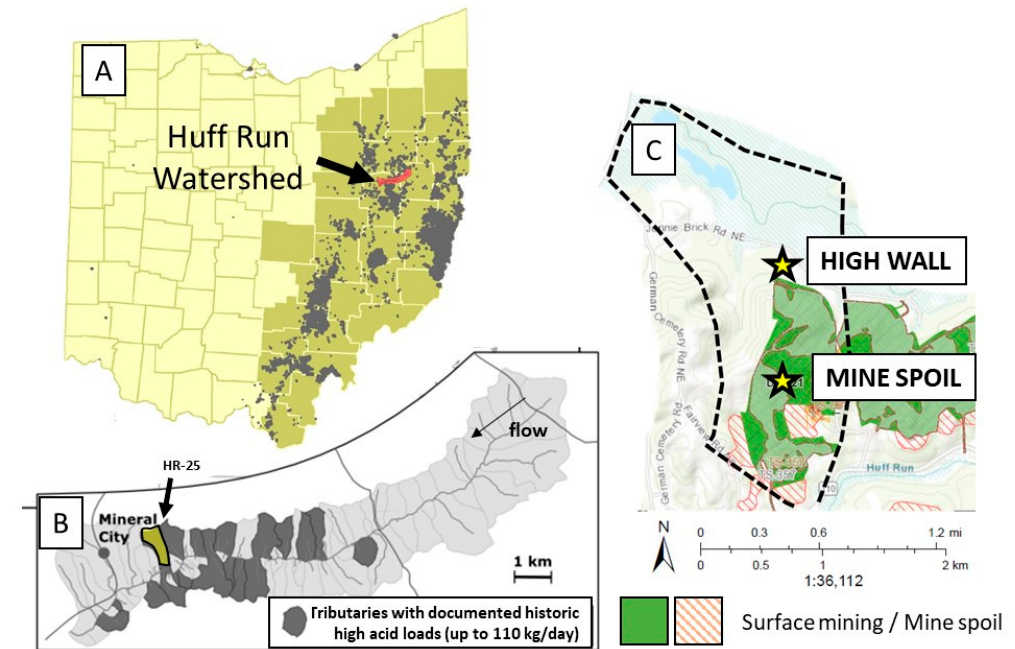
Figure 1. ( A ) Location of the Huff Run Watershed (in red), with Ohio coal counties shown in tan and known abandoned coal mines in gray [1]; ( B ) Watershed map [27] showing location of sub-watershed HR-25 (in yellow), stream flow direction, and acid loads in portions of the watershed ( C ) spatial extent of known surface area within HR-25 (the dashed outline) affected by coal surface mining (green) and mine spoil emplacement (hatched orange). Location, watershed, and sub-watershed maps modified after [8,22]. The stars mark the locations of the high wall and mine spoil sites. Coal mining data from: https://gis.ohiodnr.gov.